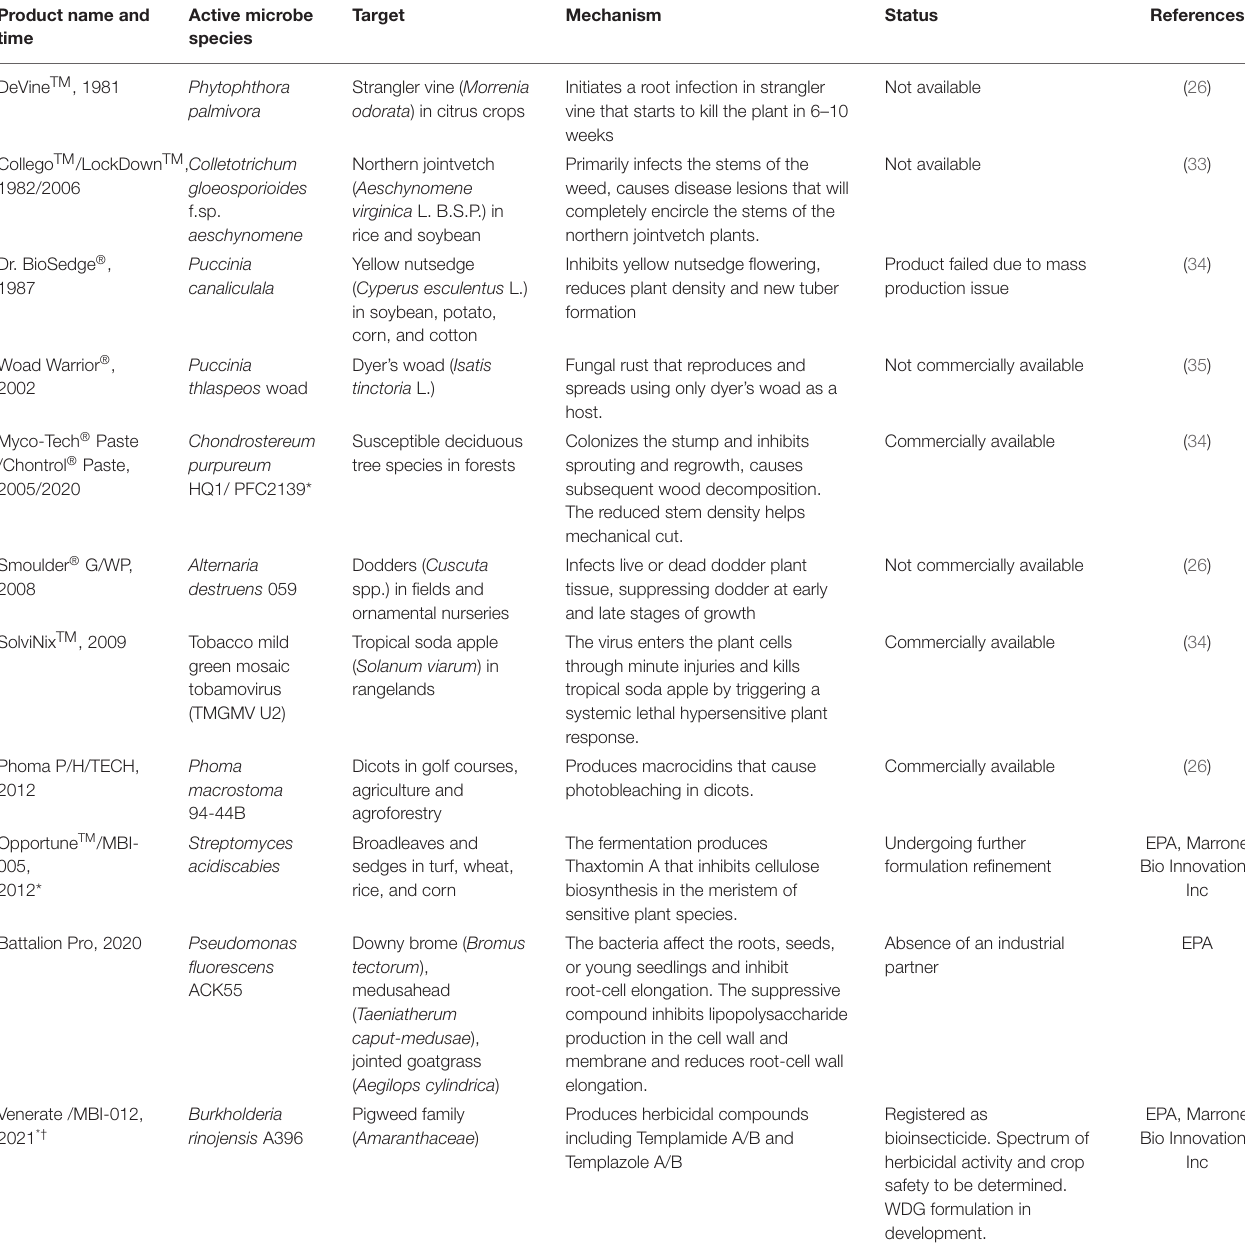
TABLE 1 | Registered bioherbicides in the United